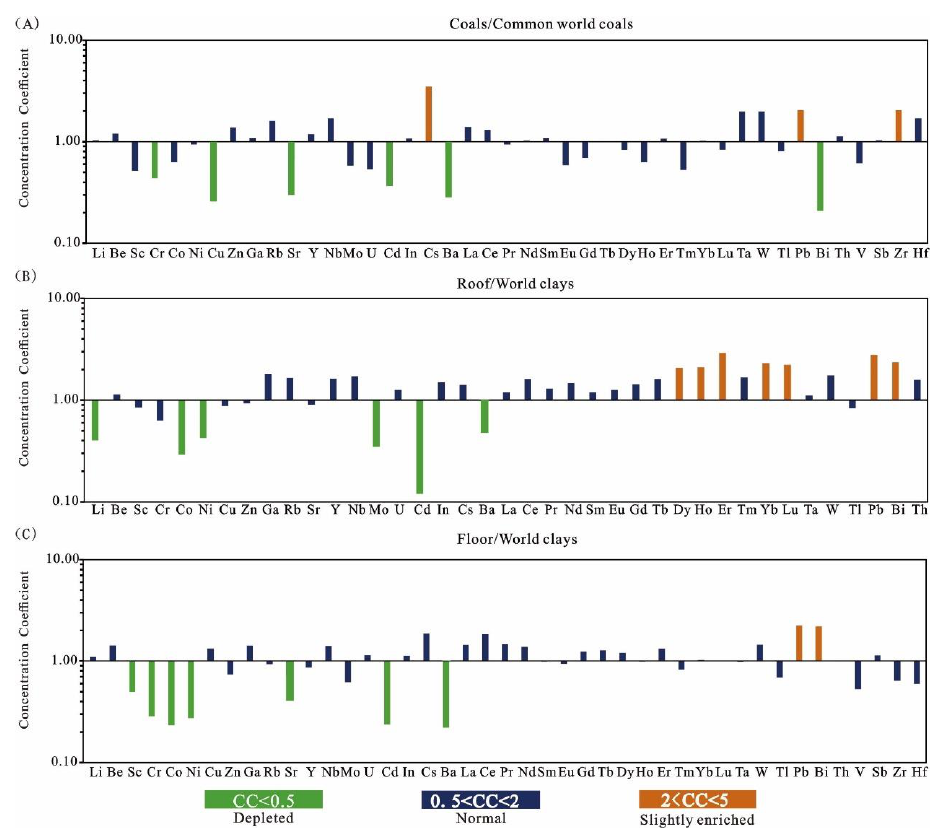
Figure 5. CC [48] of trace elements in ( A ) coals, ( B ) the roof, and ( C ) the floor in the Junde mine. Average concentration of trace elements of world hard coals is used to normalize the corresponding element concentration in studied coal samples [53]. Average concentration of trace element of world clays is used to normalize the corresponding element concentration in the studied roof and floor samples [54].